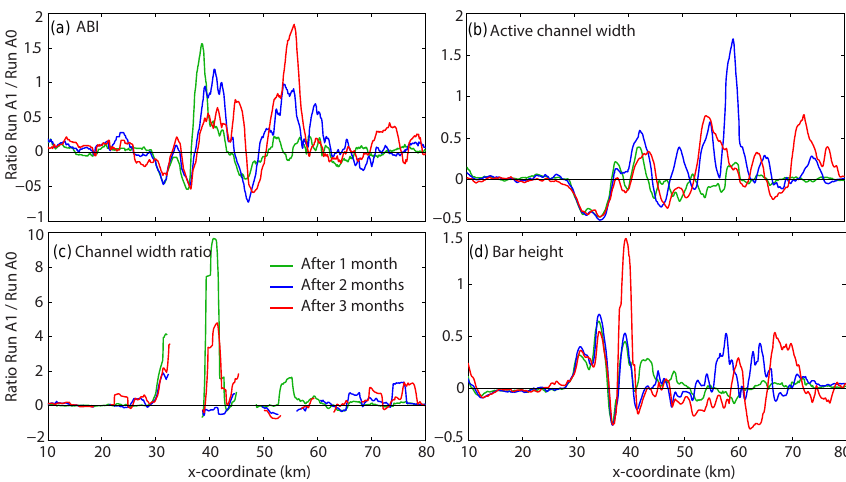
Figure 9. Effect of the disturbance in Run A1 on bar pattern statistics along the river, given as a ratio of Run A1 to the reference Run A0. The dam is located at x = 32km. A moving average filter of 2.5km was